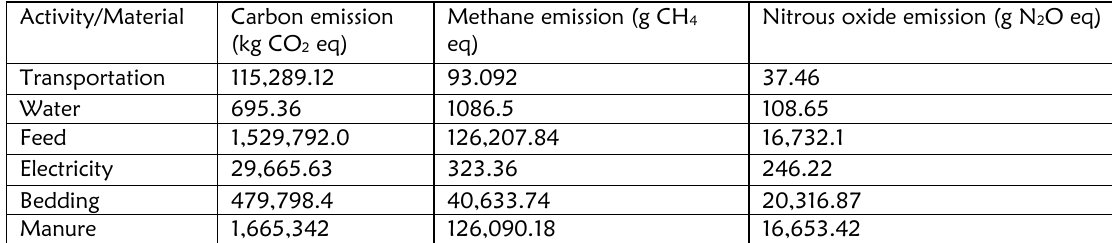
Table 5: Greenhouse gas emission from broiler chicken